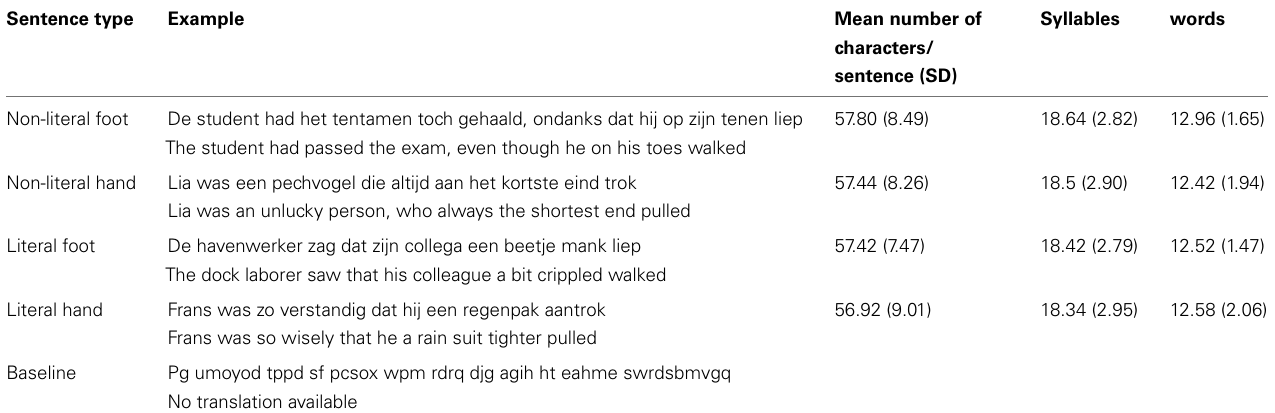
Table 1 | Example sentences and their literal